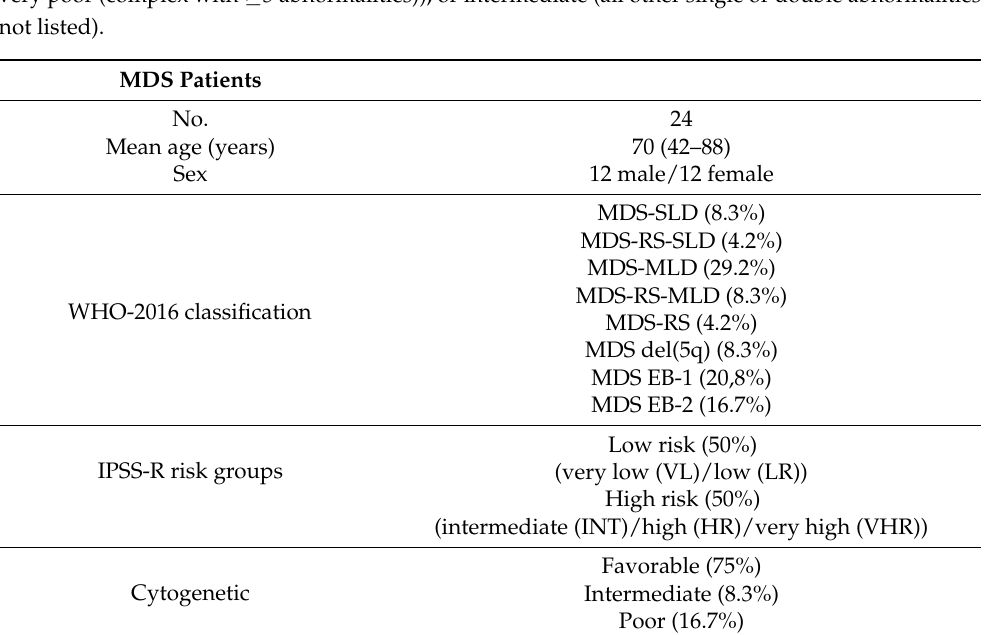
Table 1. Biodemographic and clinical characteristics of myelysplastic syndrome (MDS) patients. MDS-SLD: MDS with single-lineage dysplasia; MDS-MLD: MDS with multilineage dysplasia; MDS with SLD and ring sideroblasts (MDS-RS-SLD); MDS with MLD and ring sideroblasts (MDS-RS- MLD); MDS-RS: MDS and ring sideroblasts; MDS del(5q): MDS with isolated del(5q); MDS EB-1, -2: MDS with excess of blasts-1;-2.IPSS-R: Revised International Prognostic Scoring System; VHR: very high risk; HR: high risk; INT: intermediate; LR: low risk; VL: very low risk. Cytogenetic